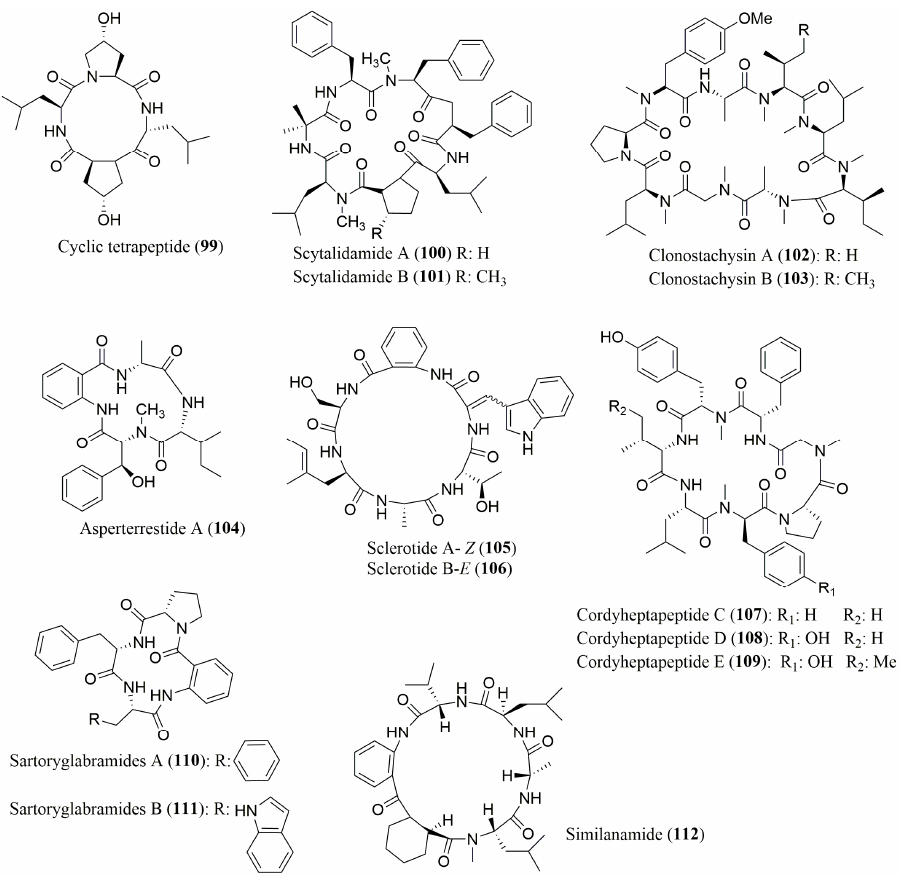
Figure 8. Structure of cyclic peptides 99 – 112 , isolated from marine-derived fungi.